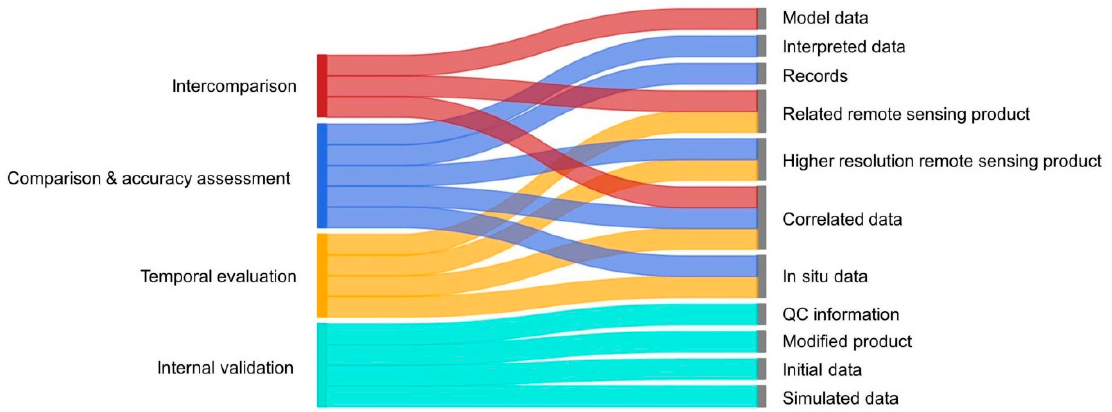
Figure 10. Categorization of validation methods by the use of validation data.